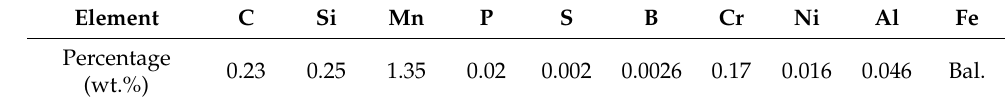
Figure 1. The initial state of galvannealed (GA), galvanized (GI) and Al–Si coatings: ( a ) GA coating; ( b ) GI coating; ( c ) Al– Si coating. Table 1. The chemical compositions of boron steel B1500HS.